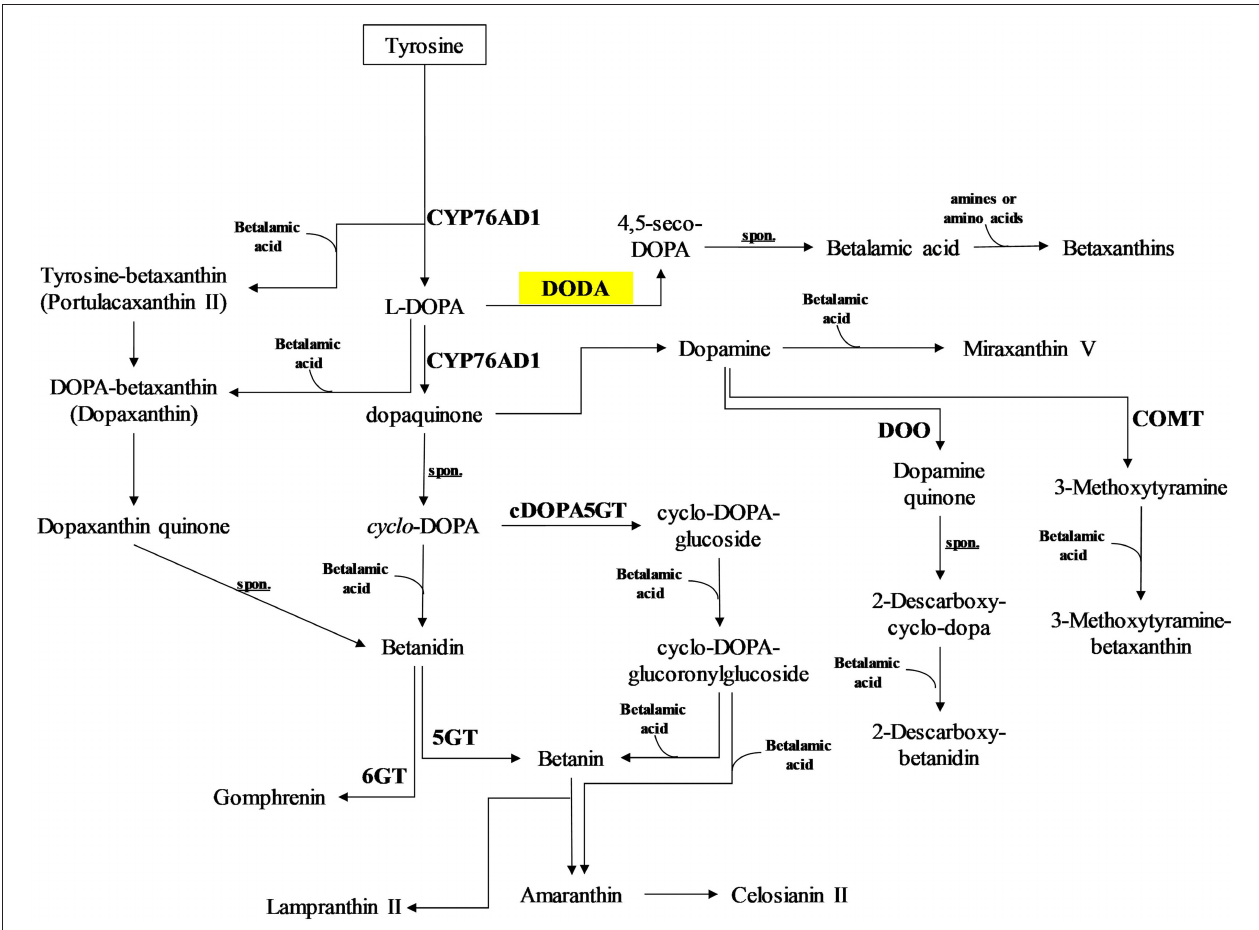
FIGURE 4 | DEG genes related to betalain synthesis pathway. Green squares indicate down regulated genes. Yellow squares show both up and downregulated genes.